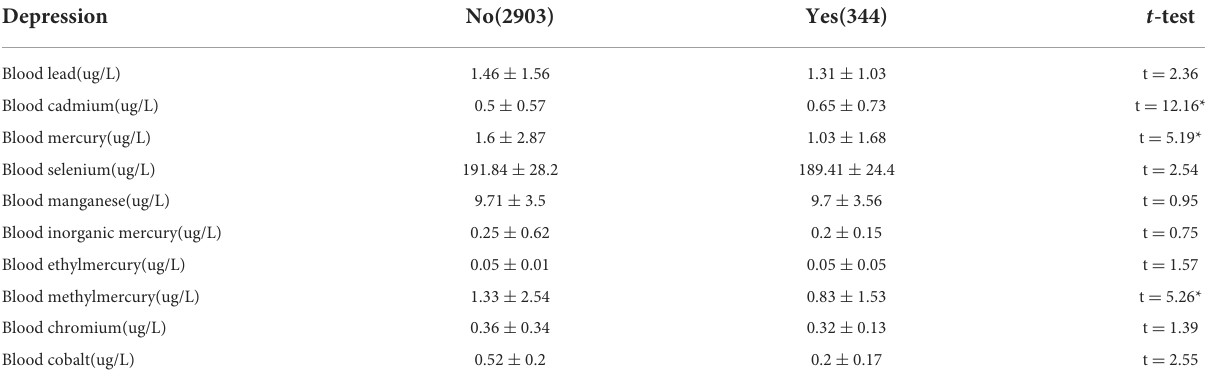
TABLE 2 Environmental heavy metals of adults aged 40 years or older by depression in NHANES 2017–2018.